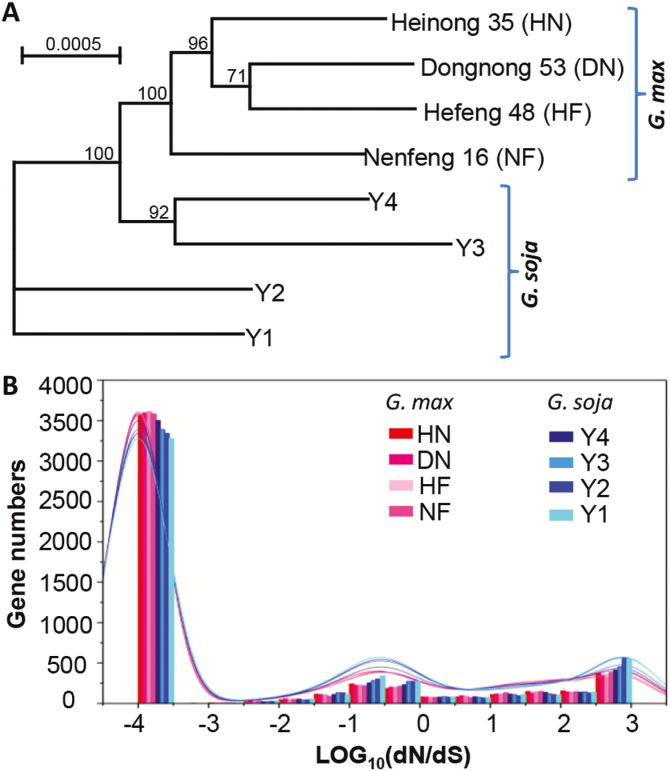
Sequence diversity of wild and cultivated soybeans. (A) Unrooted NJ tree of wild and cultivated soybeans using the identified orthologous genes. The scale bar represents the expected number of substitutions per site. (B) The distribution of the dN/dS ratio. The red, purple, pink, deep pink, dark blue, blue, gray, and turquoise lines represent dN/dS distributions of single-copy orthologous genes of cultivated soybeans (HN, DN, HF, and NF) and wild soybeans (Y4, Y3, Y2, and Y1).